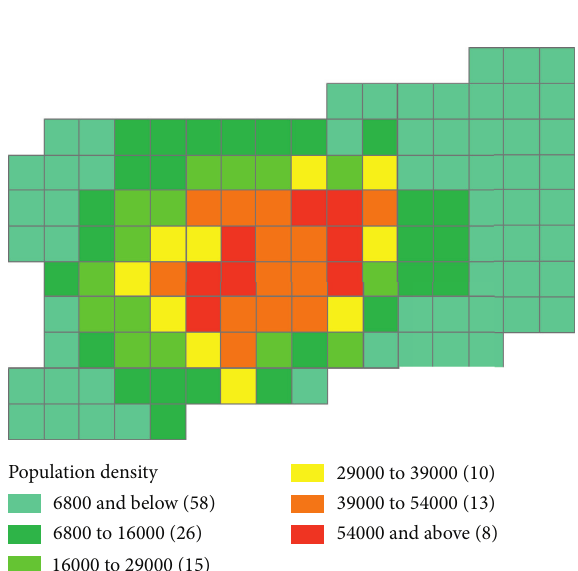
Figure 4: Road network density (unit: km/square